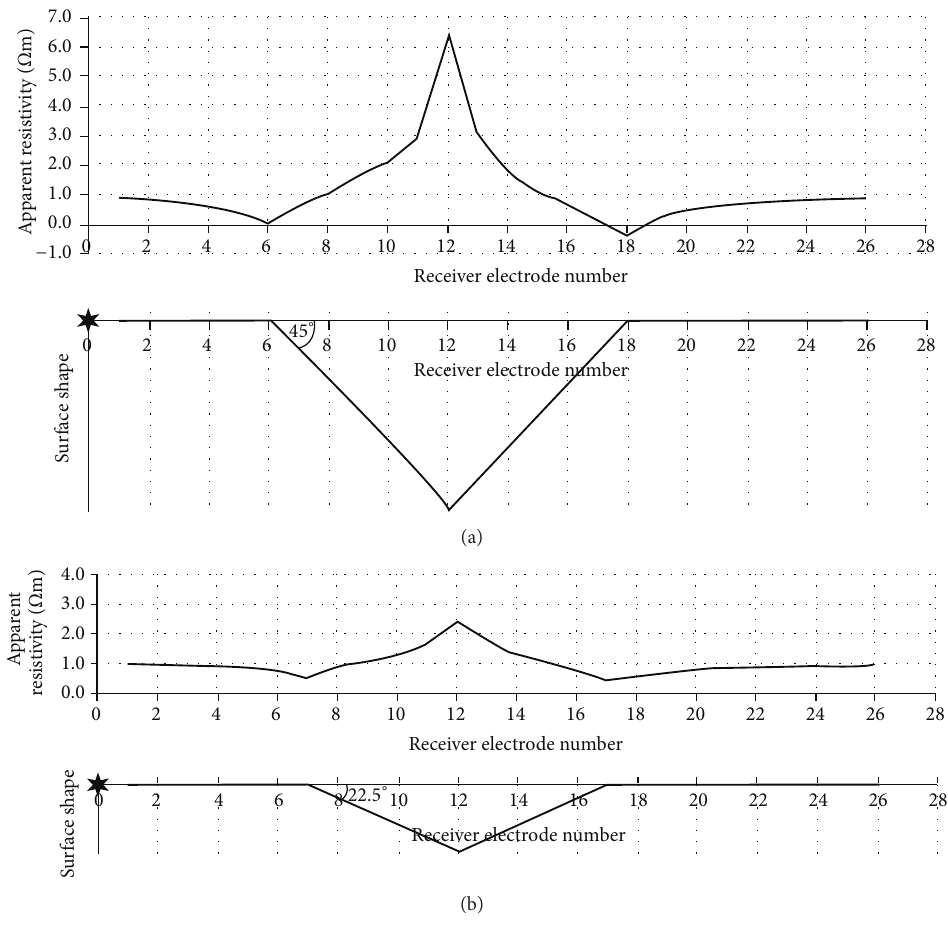
Figure 7: The form of the ground surface and 𝜌 𝑎 curves for a three-electrode array where the model surface has negative shape of symmetrical triangle. A star indicates the position of the current source electrode. (a) The angle of 𝛼 = 45 ∘ ; (b) the angle of 𝛼 = 22.5 ∘ .